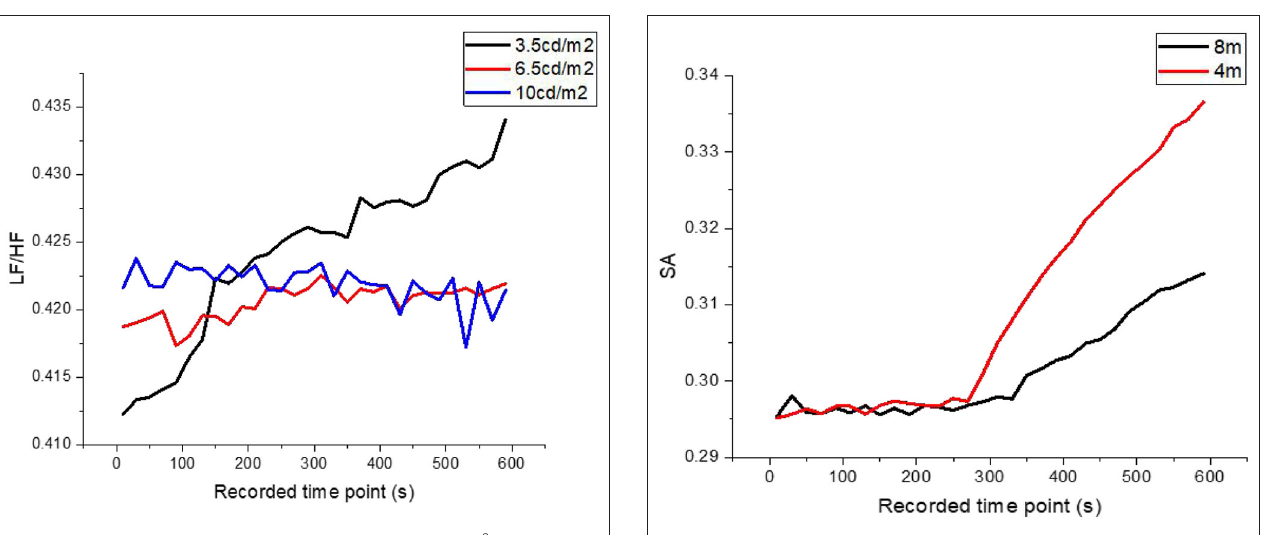
as possible. Increasing the level of pavement luminance will cause waste of energy consumption.